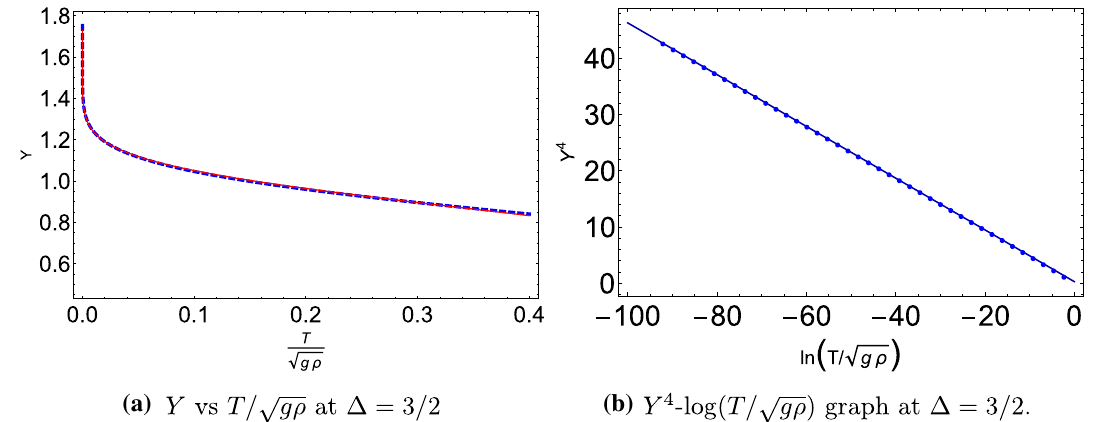
√ Fig. 16 a Y vs T / g ρ : red colored curves for Y is a plot of Eq. (A.50). And blue dashed curves is a plot of Eq. (A.51). These two curves are √ g ρ) graph at (cid:2) = 3 / 2: The slope of blue dotted line for Y 4 is − 0 . almost identical for low temperature. b Y 4 -log ( T /